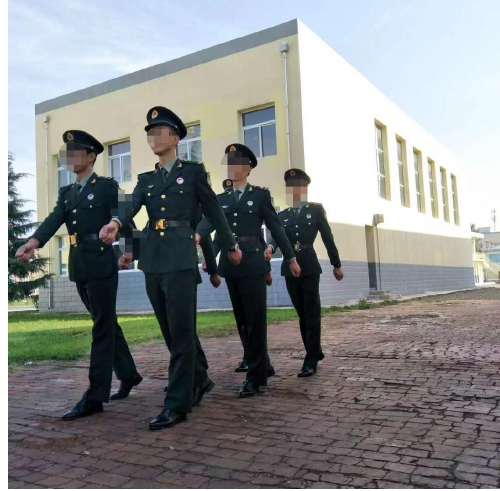
Figure 1. Walk together in a